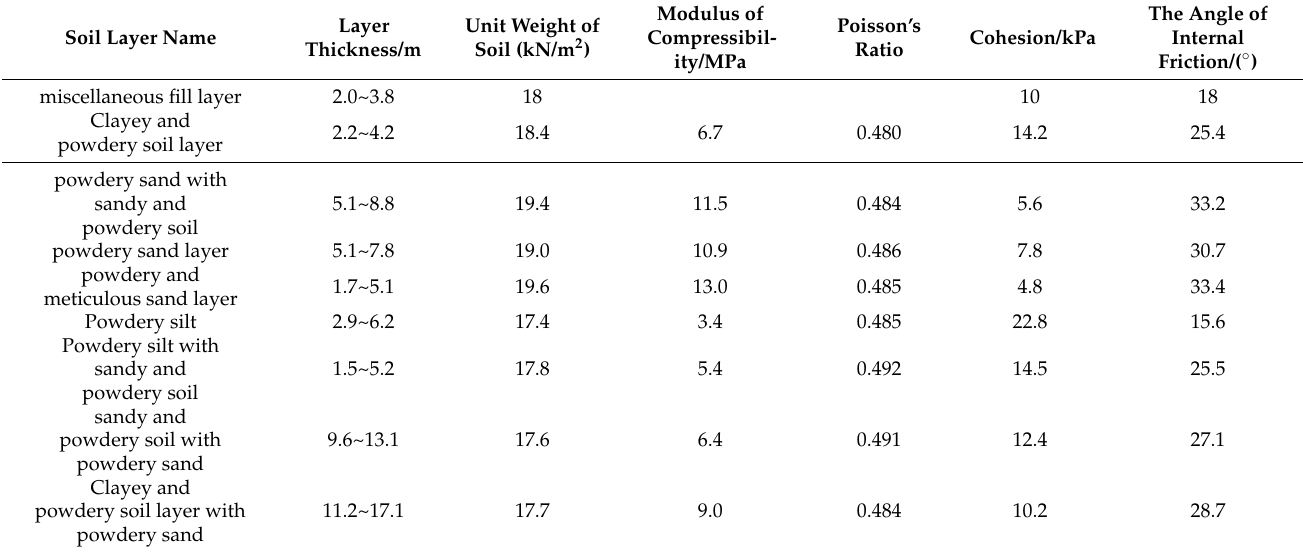
Table 1. Mechanical parameters of rock mass of deep foundation